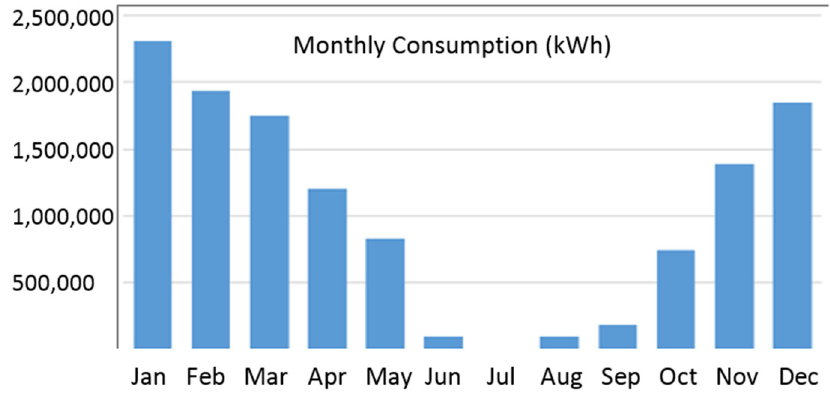
Figure 6. The monthly thermal energy consumption of PTC buildings.